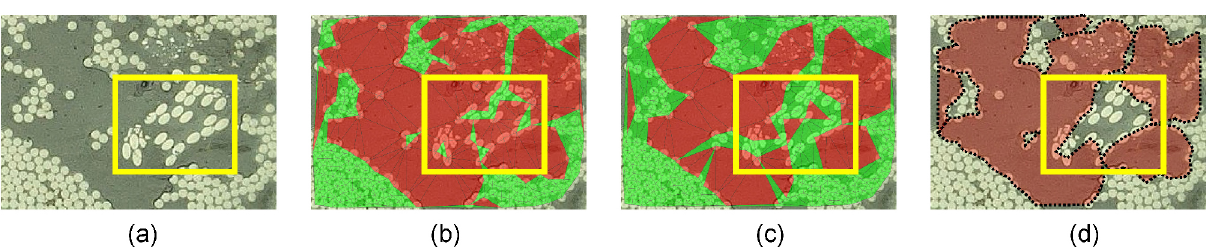
Fig. 24 Comparison between our method and a spatial tessellation (Delaunay) based approach [7]: (a) input, (b) Delaunay approach with low threshold; (c) Delaunay approach with higher threshold, (d) our result. Yellow squares indicate regions with densely distributed misaligned fibers, which should not be identified as fiber-deficient areas.